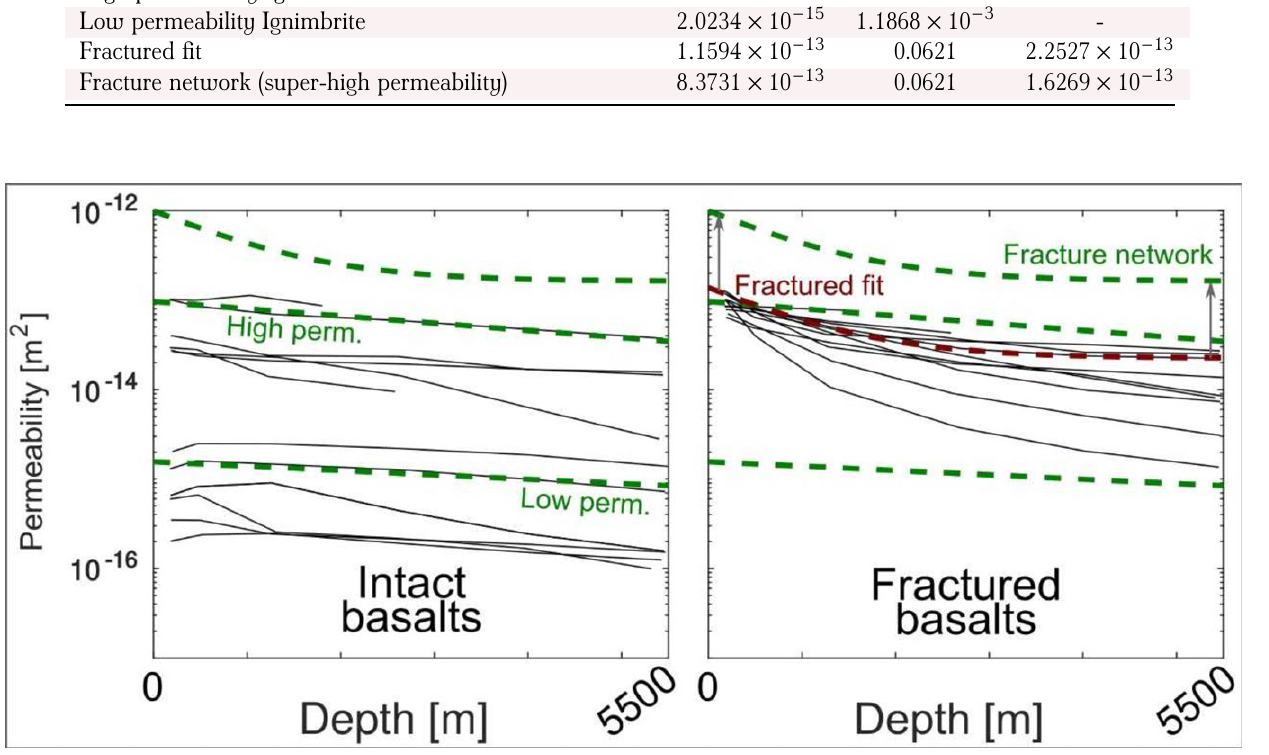
Figure D9: Exponential permeability functions shown in Table D1 compared to the experimental permeability as a function of effective pressure data for intact and fractured basalts from Eggertsson et al. [2020]. Conversion to depth was done assuming hydrostatic conditions. The super-high permeability models (fracture network) use a shifted curve corresponding to a fractured basalt (fractured fit).The shift has the curve start at 1 × 10 − 12 at 0 m